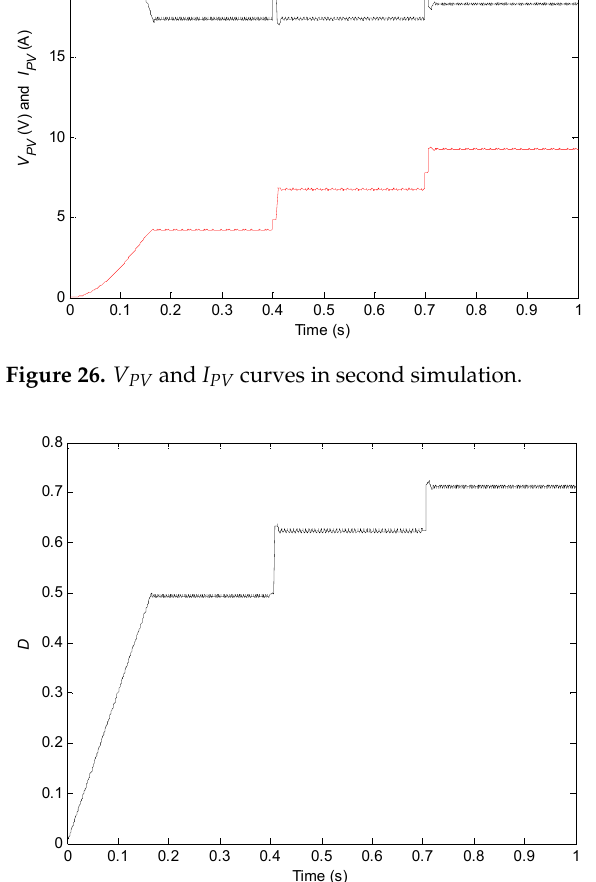
Figure 27. Duty cycle curve in second simulation.